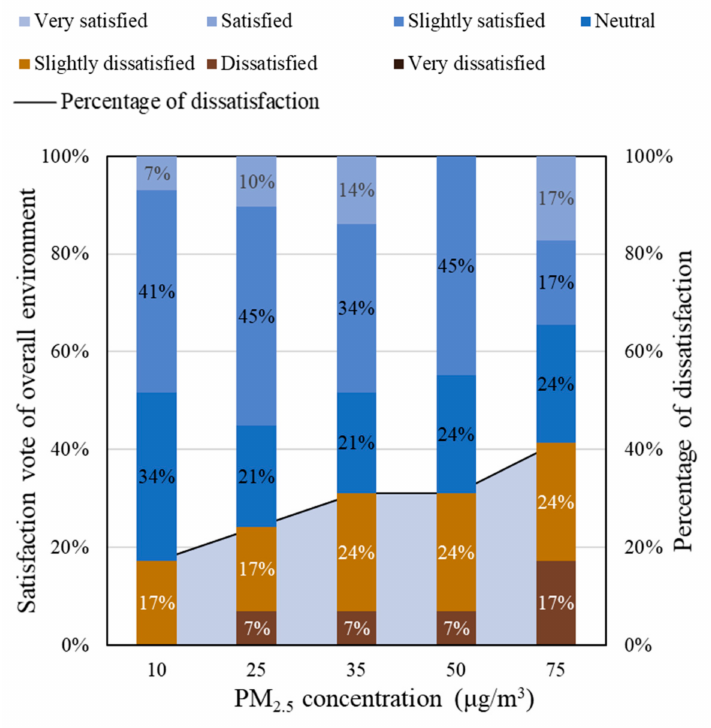
Figure 6. Satisfaction vote and percentage of dissatisfaction of overall